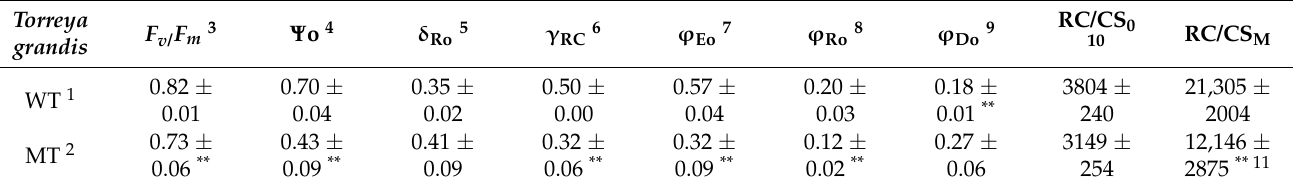
Figure 2. The PF, DF, and MR kinetics in leaves of MT and WT Torreya grandis ‘Merrillii’. Each curve is the average of three replicates. WT means wild type; MT means yellow leaf mutant type; ( A ), Prompt chlorophyll a fluorescence (PF). The signals were plotted on a logarithmic time scale. The signals used were fluorescence intensity at 20 µ s ≡ F o ; at 3 ms ≡ F J and at 30 ms ≡ F I ; maximum fluorescence intensity, F P = F m . ( B ), Delayed chlorophyll a fluorescence. The signals were plotted on a logarithmic time scale. (DF). ( C ), The decay kinetics of DF at the characteristic maxima I 1 (7 ms). The signals were plotted on a linear time scale. ( D ), Modulated 820 nm reflection (MR/MR O ). The signals were plotted on a logarithmic time scale. Table 3. Parameters derived from prompt chlorophyll a fluorescence transients in leaves of mutant- type and wild-type Torreya grandis